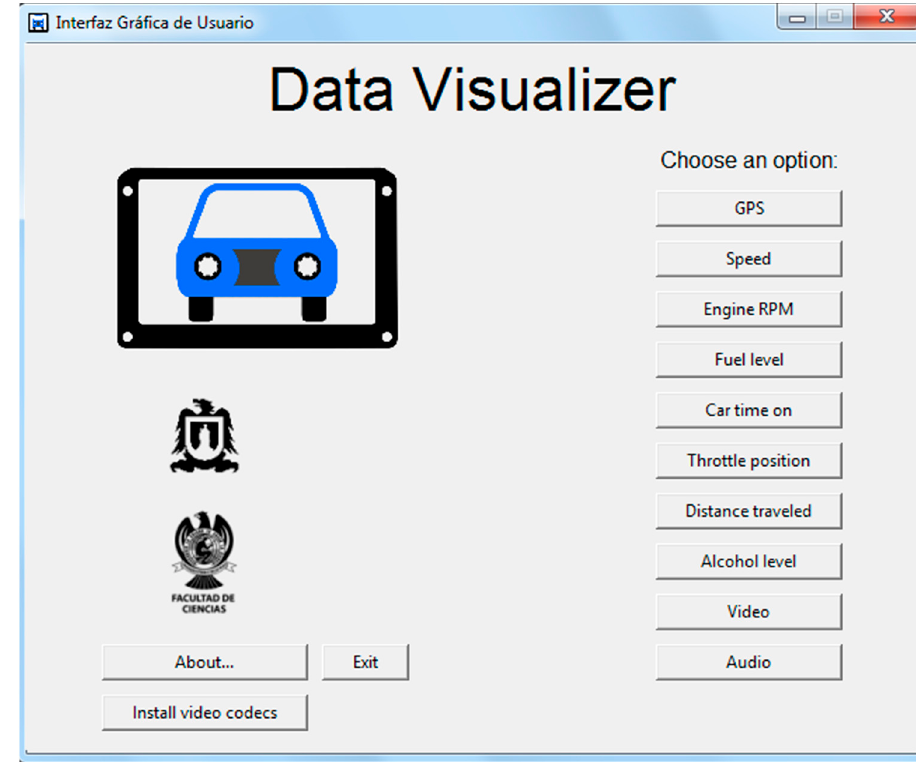
Figure 6. A screenshot of the GUI for the car’s black box system.